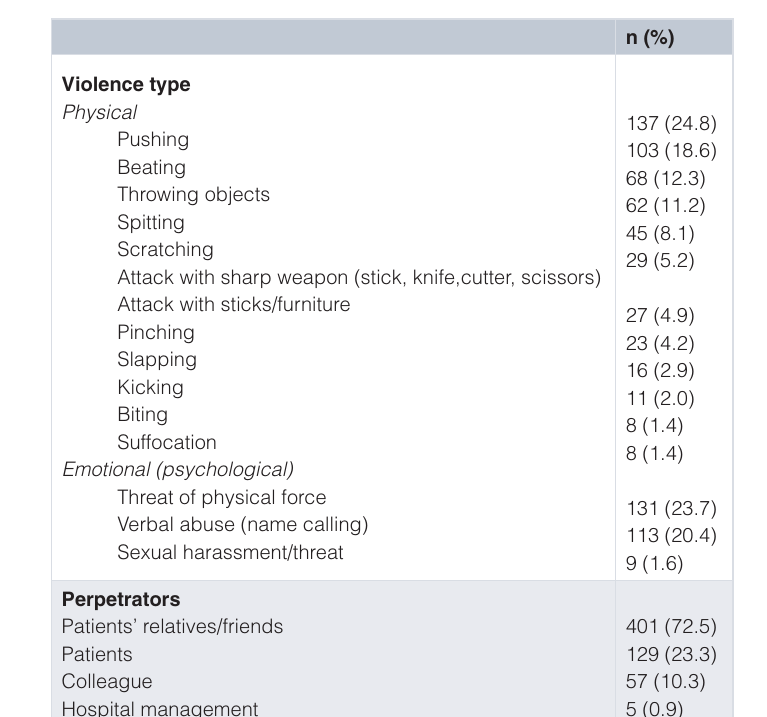
university hospital in